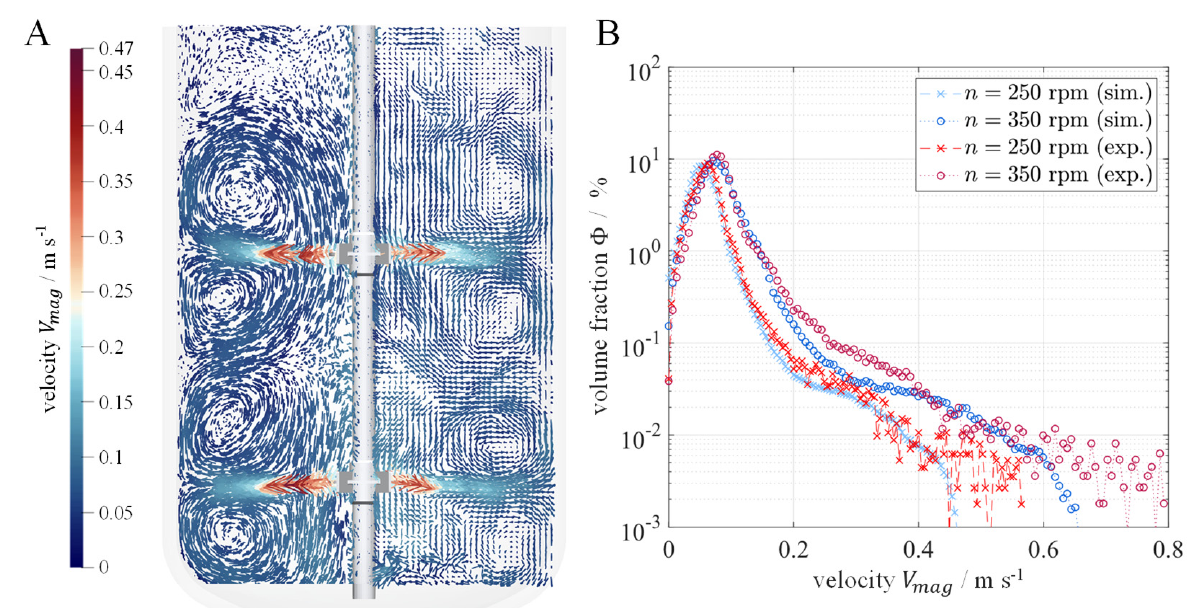
Figure 5. Comparison of simulated (left of the stirrer shaft, mirrored) and experimental (right of the stirrer shaft) velocity field depicted as slice between two baffles of the baffled system at n = 250 rpm ( A ). Experimental (red) and simulated (blue) velocity distribution (3D) of the baffled system for n = 250 rpm (crosses) n = 350 rpm (circles) ( B ).